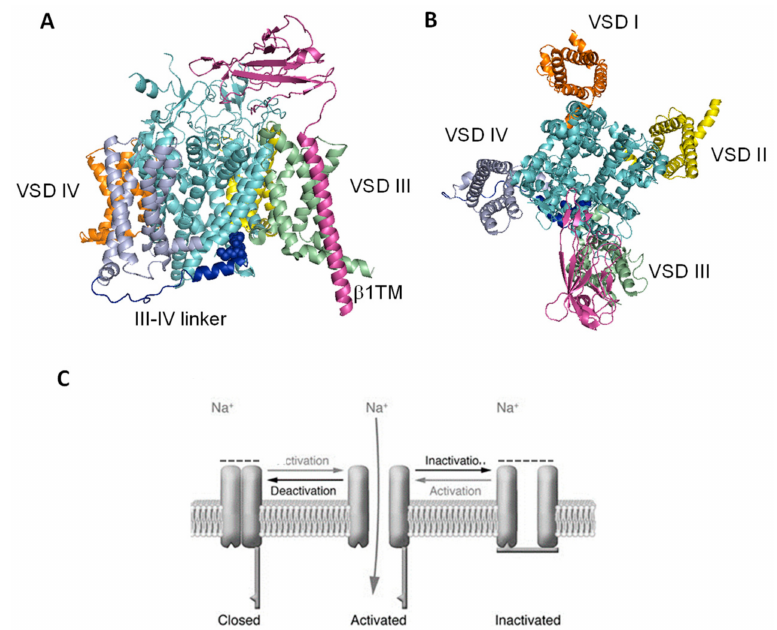
Figure 1. Structure of the human Na v 1.4-b1 complex. ( A ) Side and ( B ) top view of the human Na v 1.4-b1 complex (pdb: 6AGF; [64]). The VSDs are colored yellow, orange, green and violet. The S5–S6 helices are colored cyan. The IFM motif is shown as blue spheres, and the III-IV linker is colored blue. ( C ) Schematic representation of an NaVCh undergoing the major gating